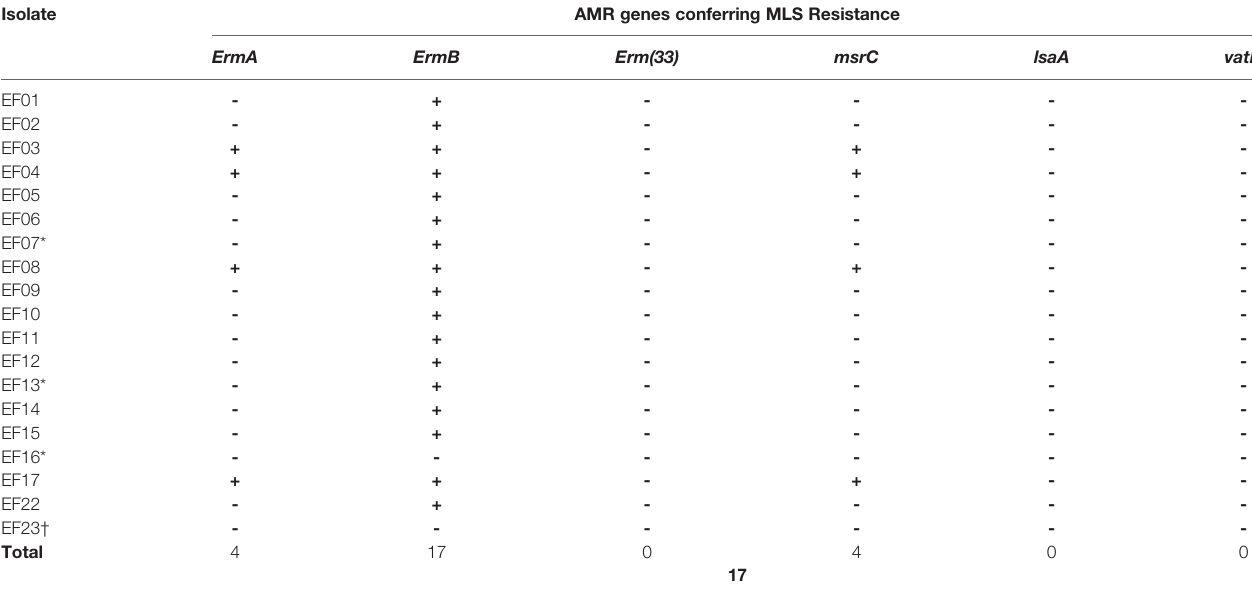
TABLE 7 | Genes detected by short-read next-generation sequencing that confer antimicrobial resistance (AMR) to macrolide – lincosamide – streptogramin (MLS). Isolate